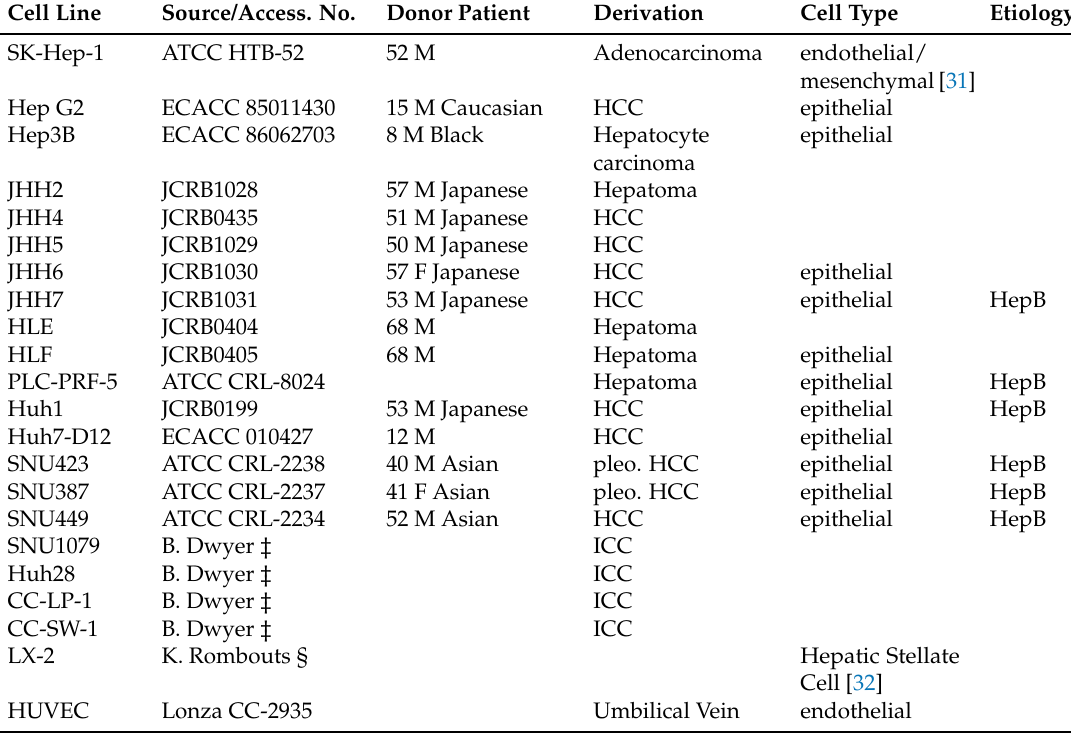
Table 1. Human cell lines used for research.